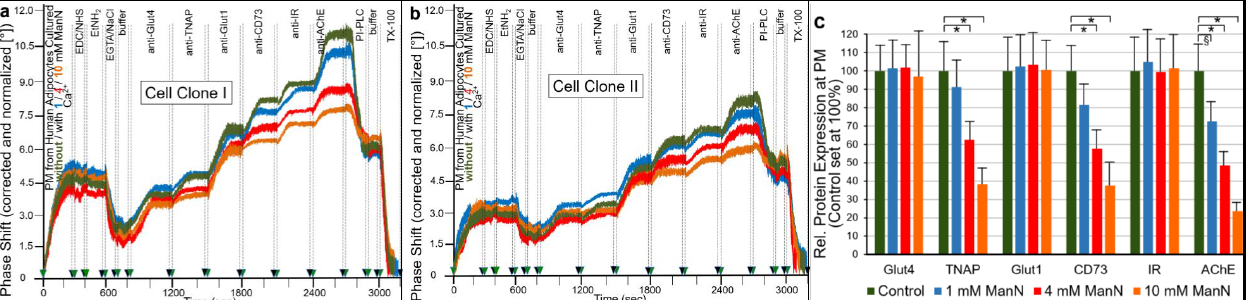
Figure 2. Lowering of GPI-AP expression at PM of human adipocytes by ManN. Human adipocytes of lipid-loading stage II (see Supplementary Materials, Methods and Figure S6) were incubated in the absence (green, control) or presence of increasing concentrations of ManN (blue, 1 mM; red, 4 mM; and orange, 10 mM) as described in the Materials and Methods. The expression of transmembrane proteins and GPI-APs at PM prepared from the adipocytes was analyzed by SAW sensing. ( a , b ) PM from two different cell clones (I,II) were analyzed using different chips. The measured phase shift is given upon correction and normalization as described in the legend to Figure 1. ( c ) The values from six independent cell clones for both control and ManN-treatment were used for calculation of the phase shift ∆ induced by each antibody (anti-Glut4, ∆ 1200–800 s; anti-TNAP, ∆ 1500–1200 s; anti-Glut1, ∆ 1800–1500 s; anti-CD73, ∆ 2100–1800 s; anti-IR, ∆ 2400–2100 s; anti-AChE, ∆ 2700–2400 s). The mean values ± SD of the phase shift ∆ were used for calculation of the relative protein expression at PM with control adipocytes set at 100% each and significant differences vs. ManN-treated ones indicated (* p ≤ 0.01, § p ≤